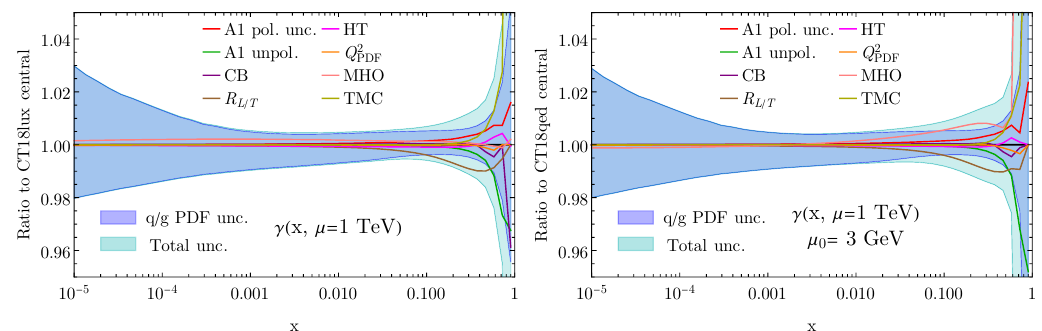
Figure 1: Comparisons of the second-generation photon PDFs and their correspond- ing error bands at µ = 1 TeV.